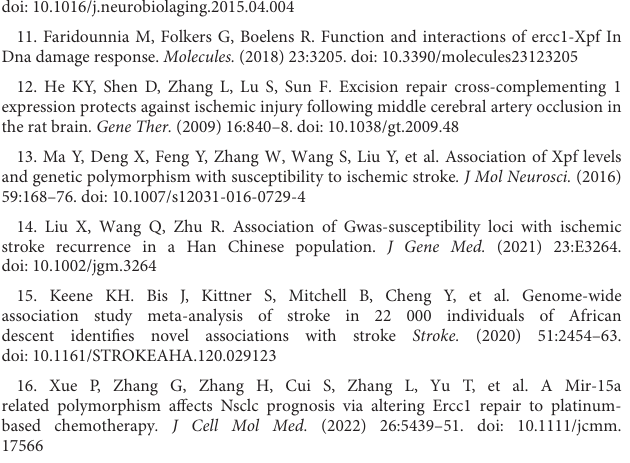
SUPPLEMENTARYFIGURES1 The sequence maps of ERCC1 rs3212986 polymorphism. (A) The sequence map of CC genotype. (B) The sequence map of CA genotype. (C) The sequence map of AA genotype. SUPPLEMENTARYTABLES1 Characteristics of the study population for analyzing ERCC1 expression